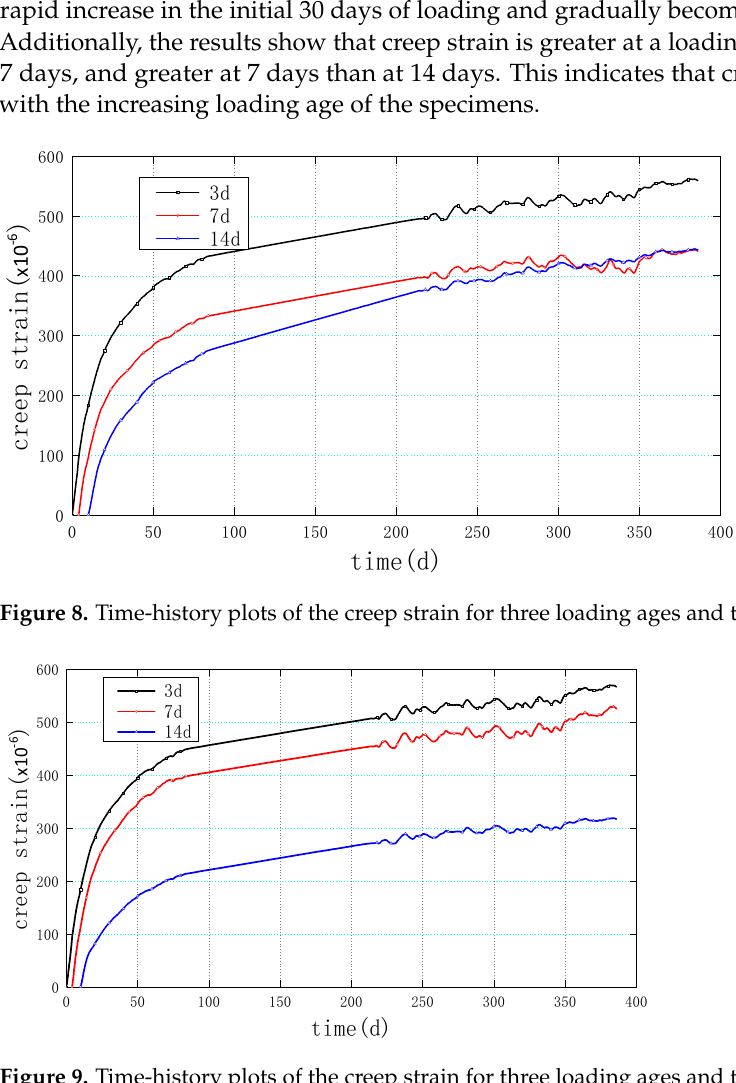
Figure 9. Time ‐ history plots of the creep strain for three loading ages and the load level of 70%. Figure 9. Time-history plots of the creep strain for three loading ages and the load level of